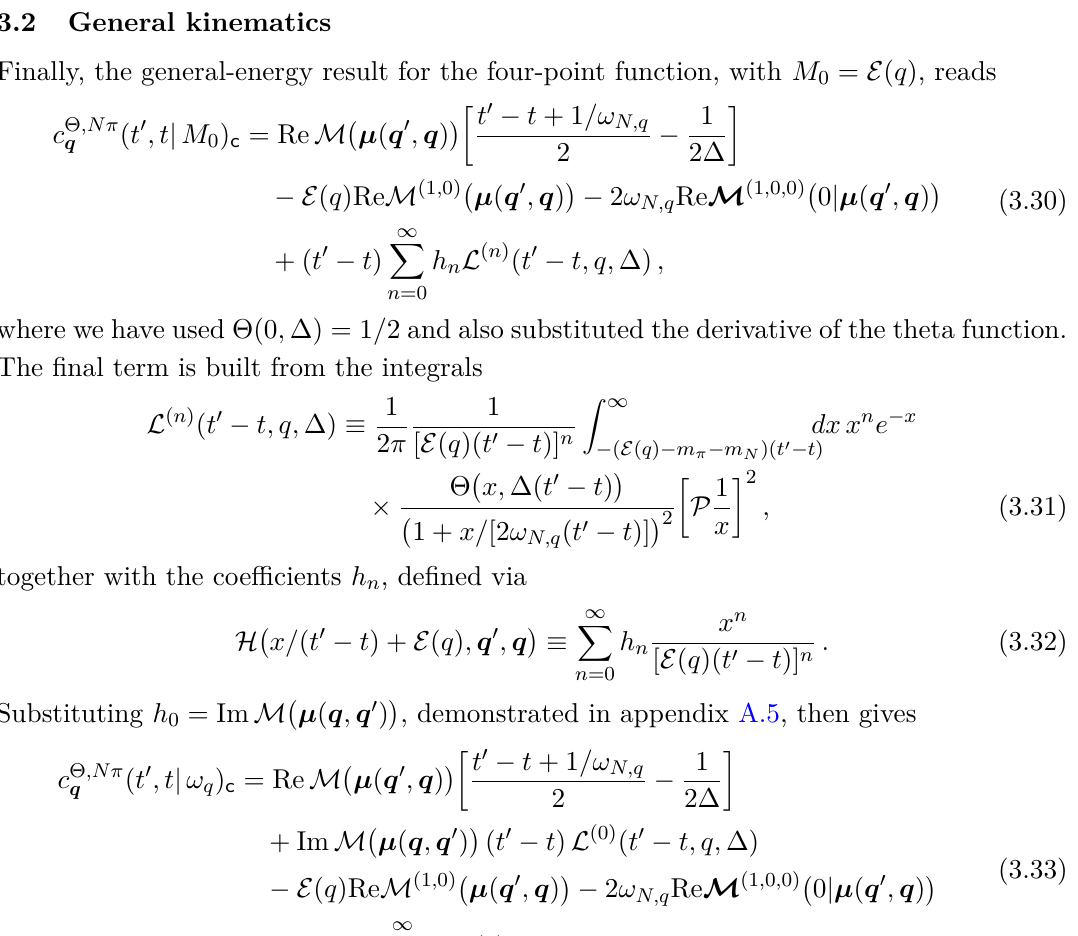
Figure 4 . Plot of the first few K ( n ) ( b, 0) functions (solid lines), defined in eq. (3.27) of the main text. The dashed lines show the large b expansion for each function, scaling as b − n − 1 / 2 as shown in eq. (3.28)